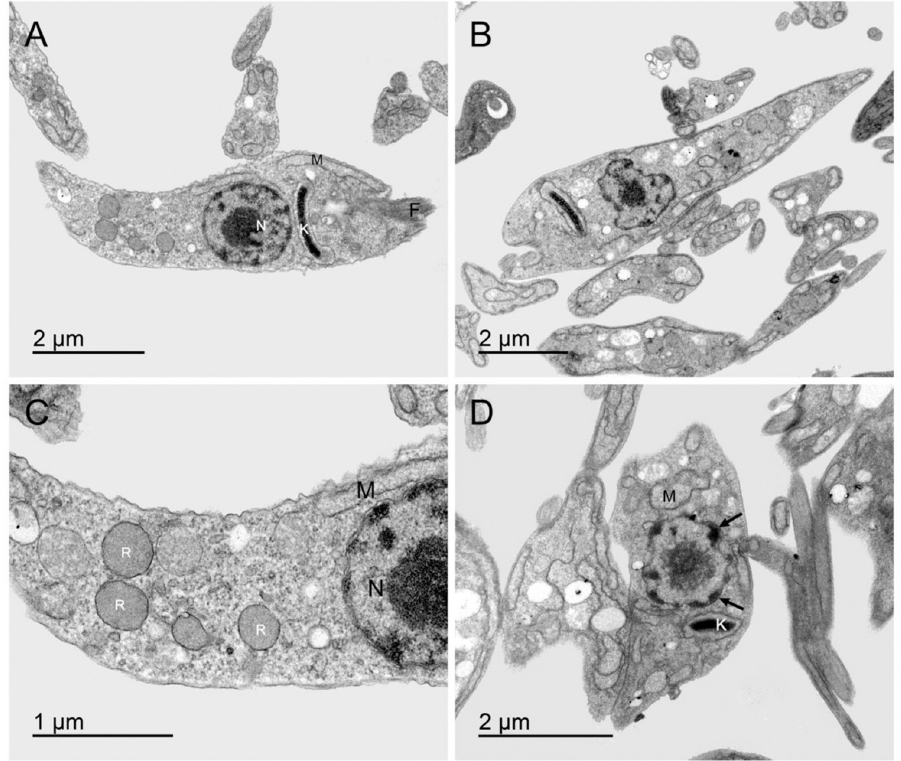
Fig 5. Transmission electron micrographs showing the ultrastructure of epimastigotes. A : Overview of control untreated. B : Overview of treatment with nimesulide for 24 h. C : Reservosomes (R), nucleus (N) and mitochondria (M) preserved in untreated control. D : Nucleus (N) with condensed heterochromatin located in sections of the nuclear envelope with a clear morphological change of this organelle (straight arrows), mitochondria (M) with altered morphology, showing very electrodense kinetoplast (K), after incubation with nimesulide.